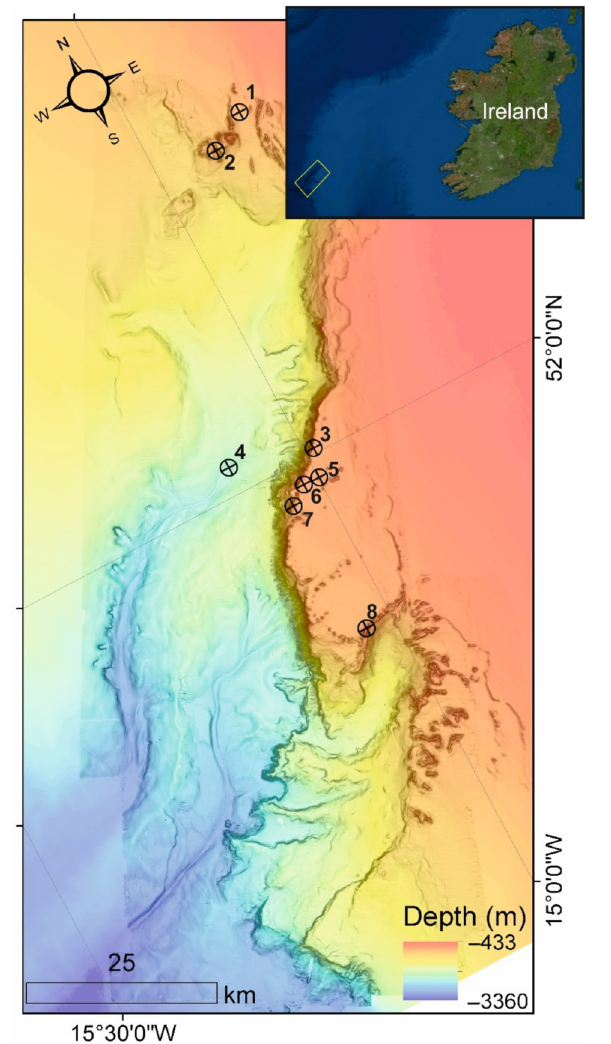
Figure 3. Map of the Porcupine Bank Canyon (main map) and its location on the Western Irish shelf (inset map). Merged bathymetry from newly acquired and existing (lower resolution) data (courtesy of INFOMAR) with Little MonSta